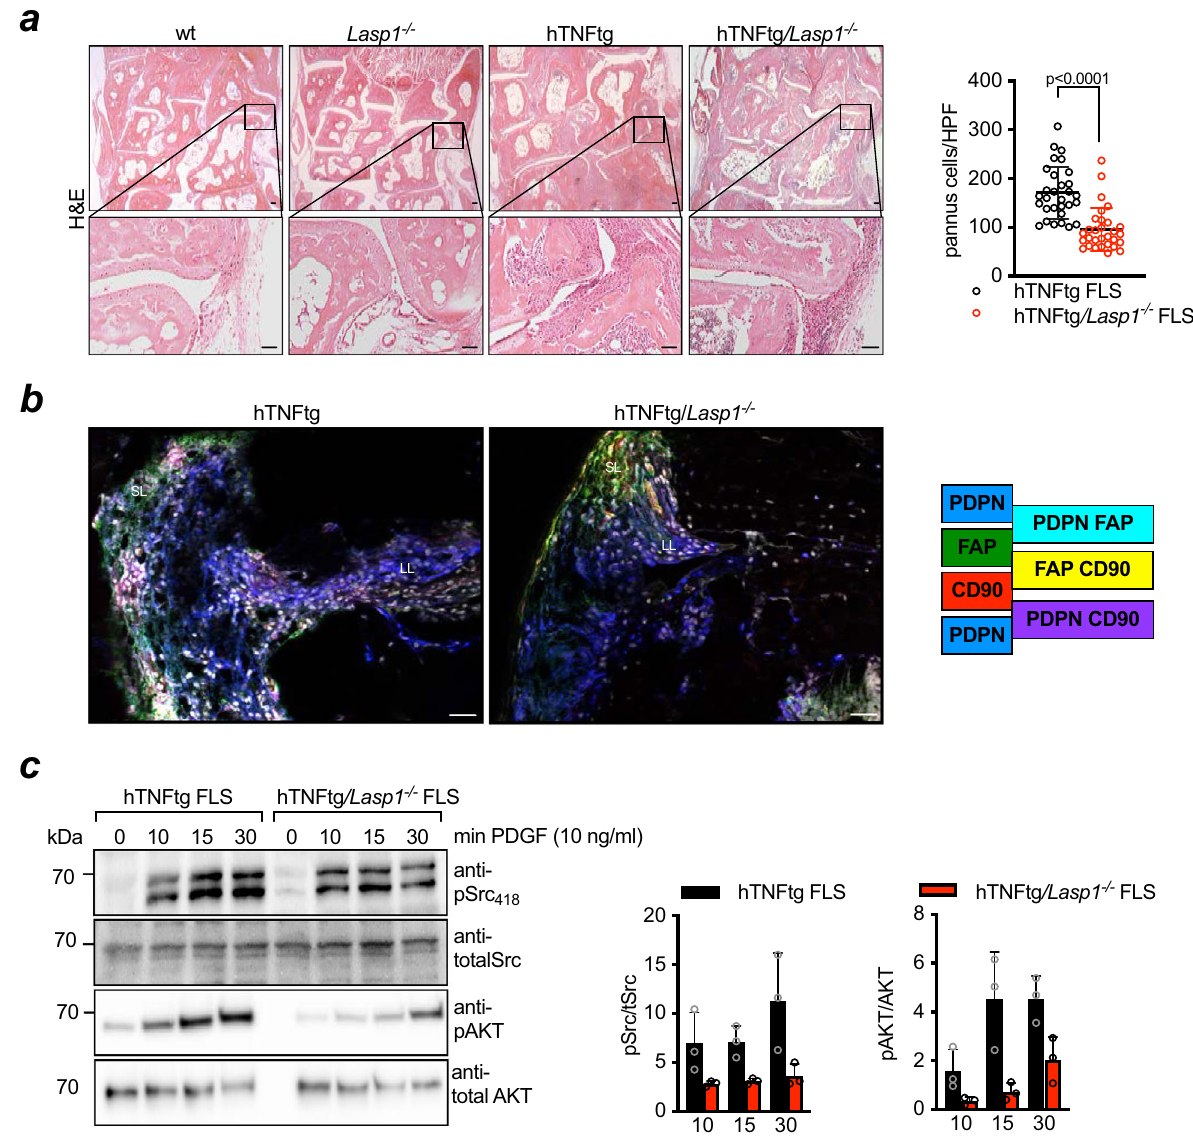
Fig. 7 Lasp1 affects tissue architecture in the synovium of hTNFtg mice. a H&E stainings (scale bar: 50 µ m) of paraf fi n sections from hind paws from 12 weeks old wt, Lasp1 − / − , hTNFtg and hTNFtg /Lasp1 − / − female mice ( n = 3 in each group). Evaluation of synovial cell density was performed by